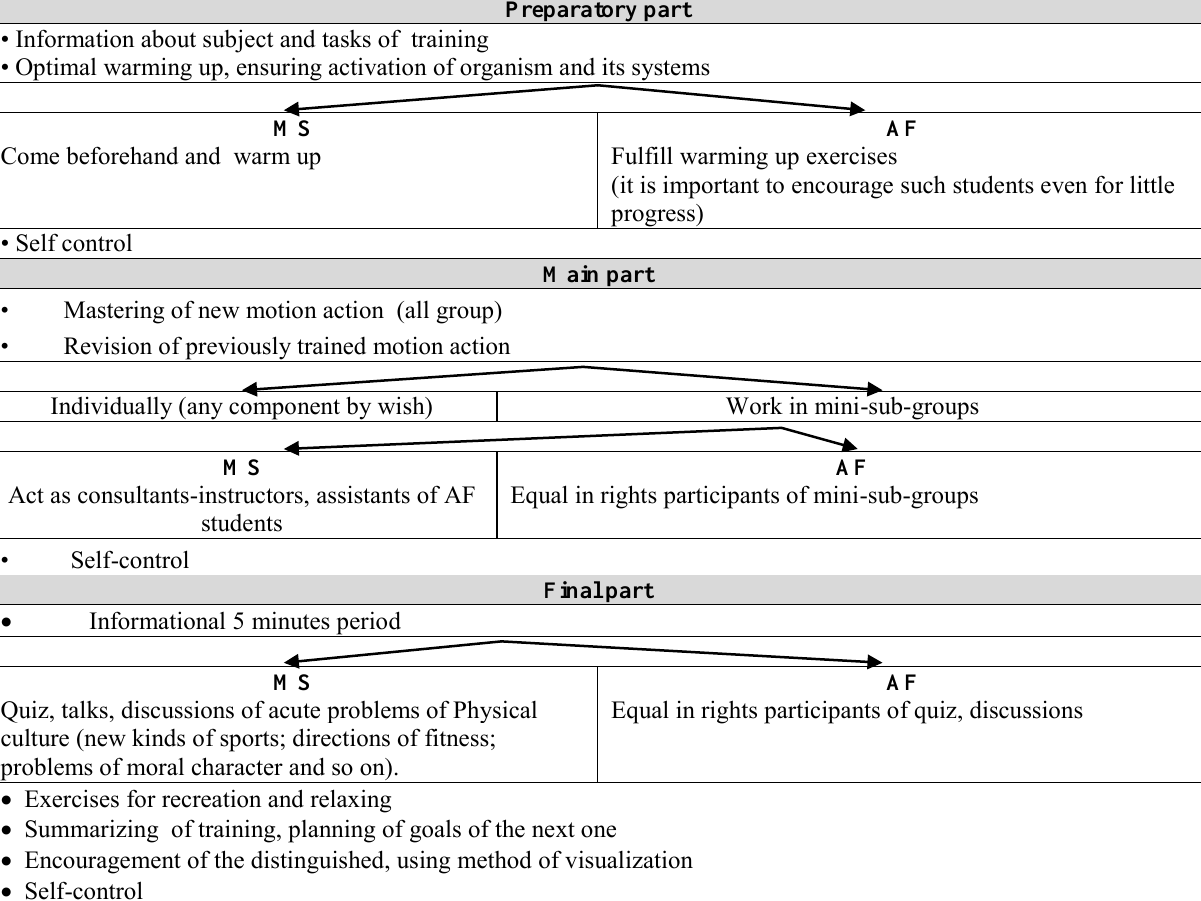
Fig.3. Model-prediction of organization of academic physical culture training, considering type of motivation for